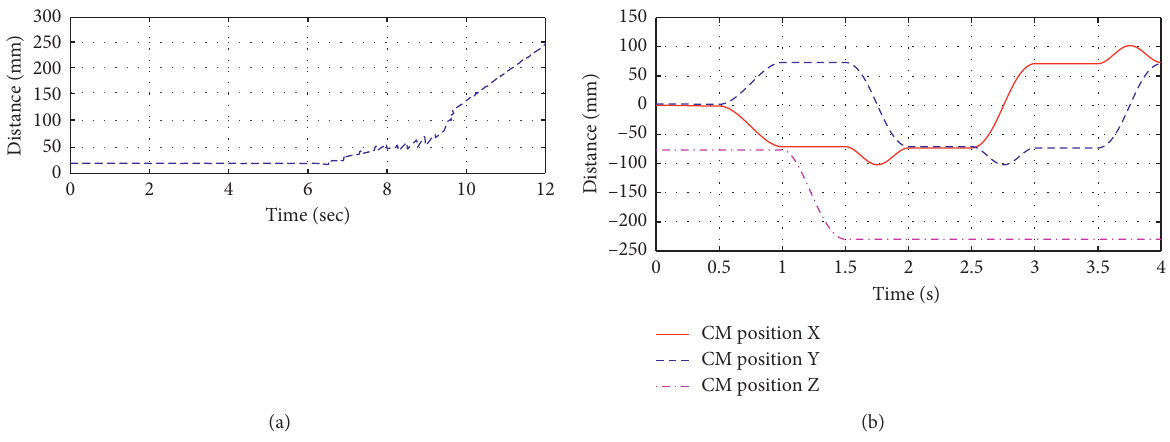
Figure 13: (a) Centroid curve of the chassis frame. (b) Centroid curve of counterweight.